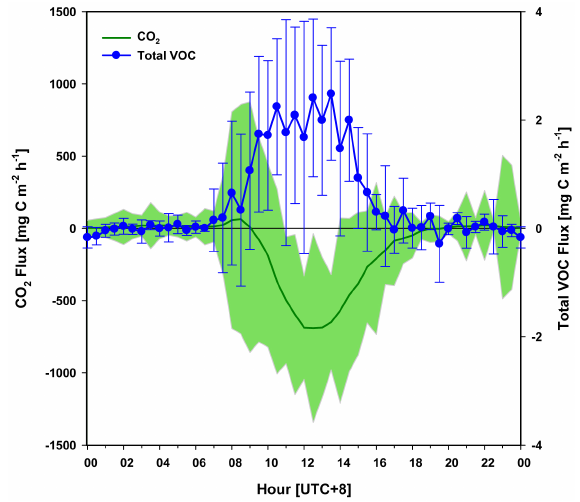
Fig. 11. Averaged diurnal profiles of CO 2 and total VOC (sum of isoprene, monoterpenes, methanol, acetaldehyde, acetone, acetic acid, MVK+MACR, hexanal and EVK fluxes) fluxes measured above a SE Asian tropical rainforest during the period of 20 June– 20 July 2008. During the night time the measurements were de- coupled from the forest canopy and therefore data shown during that period are not representative of the exchange occuring at the canopy top. Error bars and green bands show ± 1 standard devia- tion of mean averaged